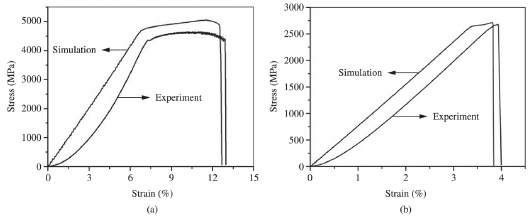
Figure 7. Comparisons between the numerical results and the measurements a) 1mm and b)